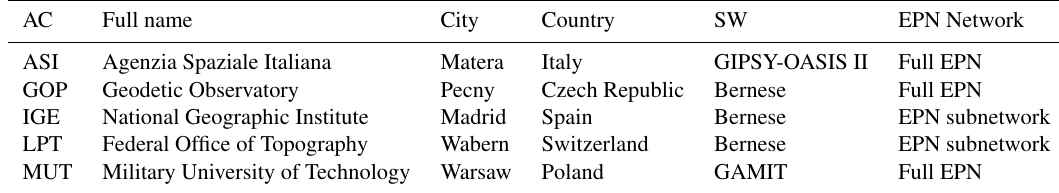
Table 1. EPN Analysis Centres providing EPN-Repro2 solutions.